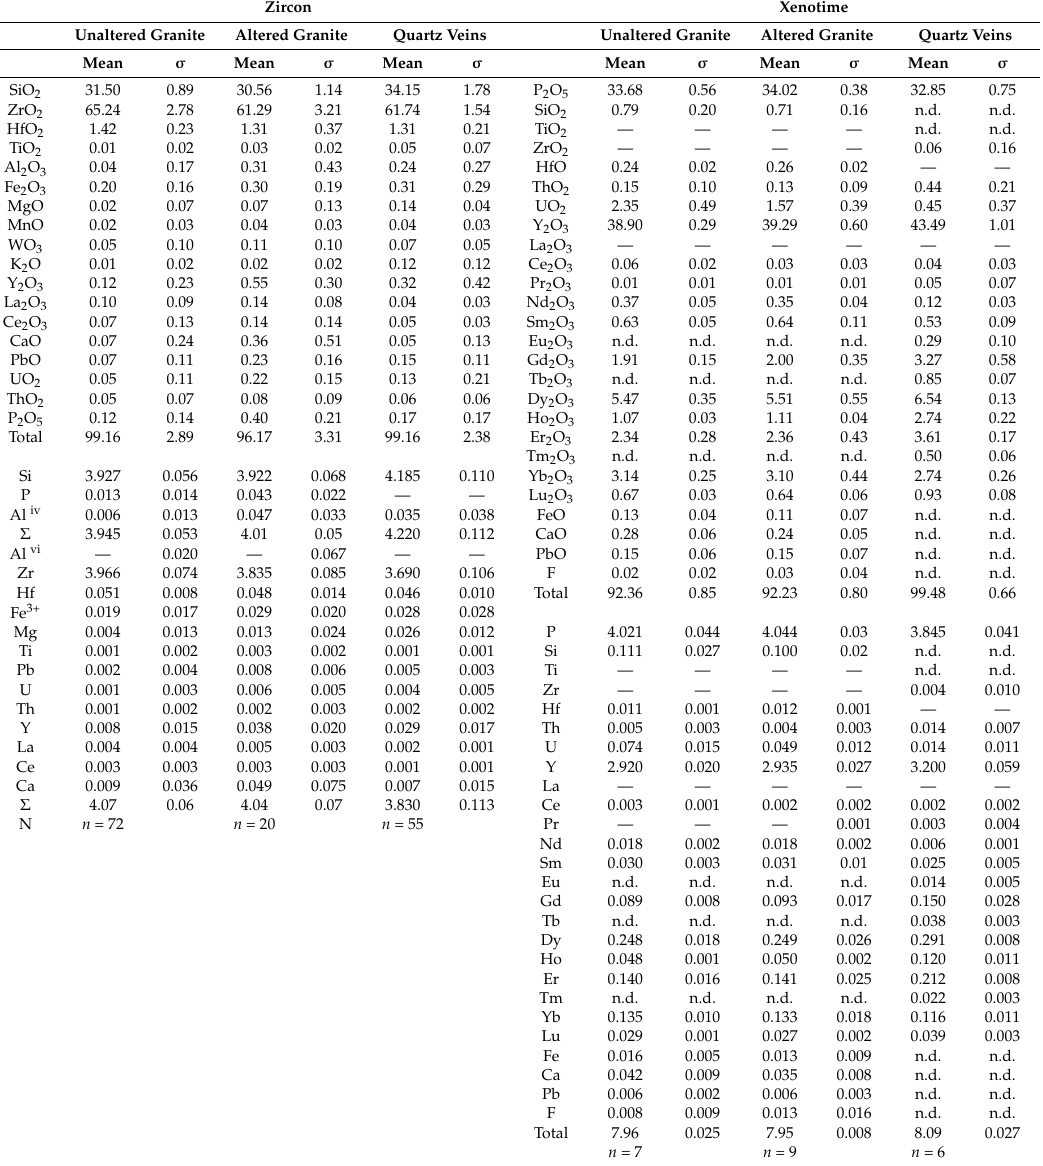
Table 2. Chemical composition (in weight percent) and structural formula of zircon and xenotime from the Variscan unaltered and altered granites, and associated hydrothermal quartz veins, Central Portugal. Zircon Xenotime Unaltered Granite Altered Granite Quartz Veins Unaltered Granite Altered Granite Quartz